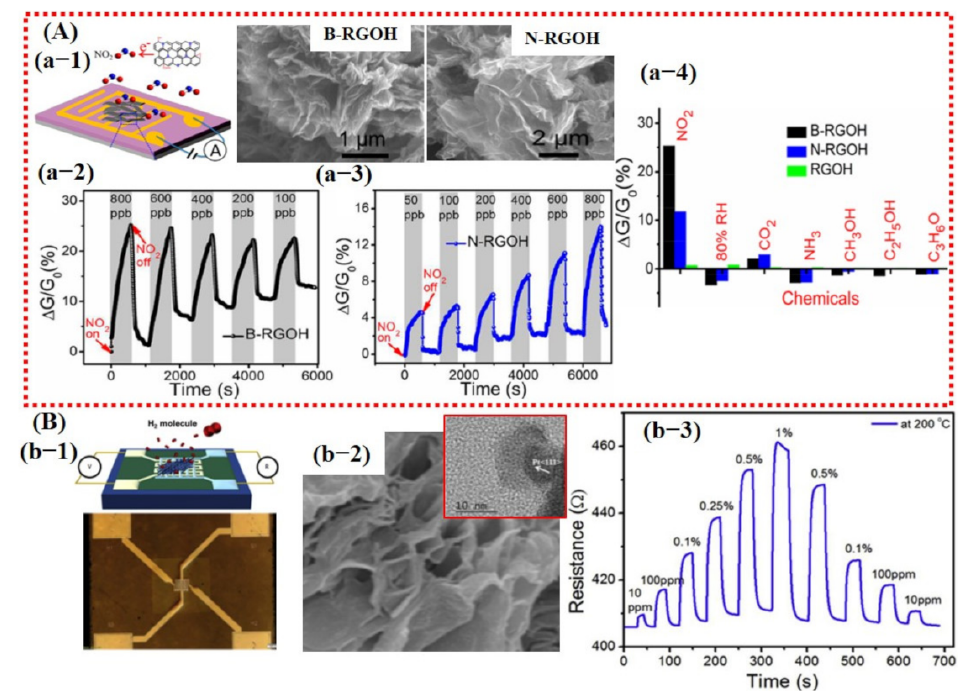
Figure 6. Representation of the sensing performances of 3D graphene: ( A ) Sensing results of B- and N-doped RGOH: (a-1) Schematic diagram of the fabricated sensor device with SEM images of highly porous B- and N-doped graphene. (a-2,3) The response of B-RGOH and N-RGOH at different concentration levels of NO 2 gas. Results show that N-RGOH revealed a good response at lower NO 2 concentration. (a-4) Responses of the B- and N-RGOH to 800 ppb NO 2 , 80% RH, 1000 ppm CO 2 , 100 ppm NH 3 , saturated methanol, ethanol, and acetone vapors. Reproduced with permission from [39], copyright 2019 ACS. ( B ) The sensing performances of Pt decorated over highly porous 3D graphene: (b-1) An optical and schematic image of fabricated sensor device. (b-2) SEM image of highly porous 3D graphene; inset shows the TEM image of Pt NP. (b-3) The symmetric response of Pt-3D graphene to various H 2 concentration levels at 200 ◦ C. Reproduced with permission from [81], copyright 2019